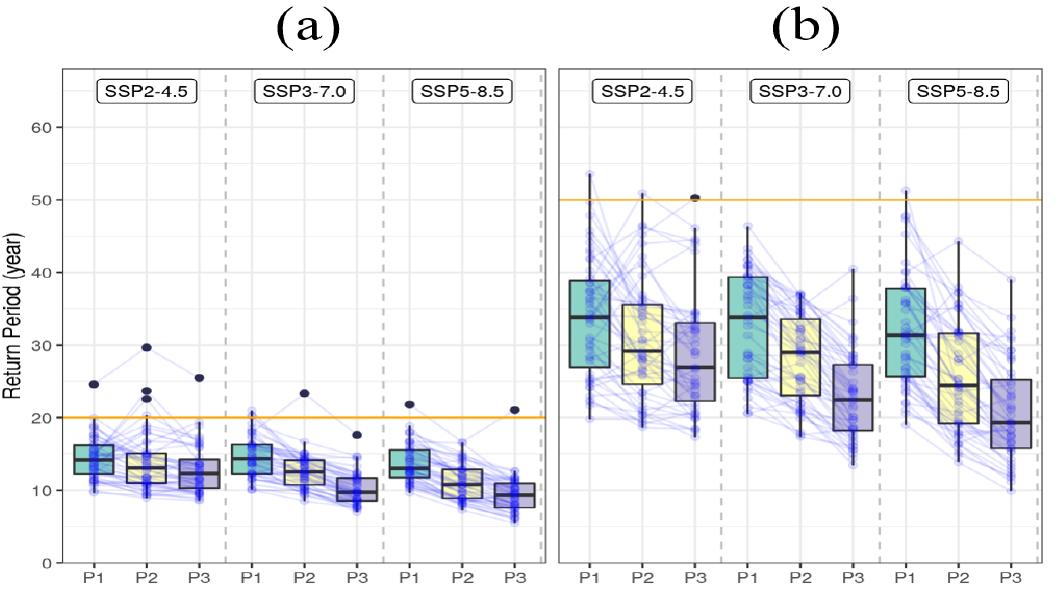
Figure 8. Parallel coordinated boxplots, similar to those in Figure 5, but for ( a ) 20-year and ( b ) 50-year return periods (unit: year) relative to the observed data from 1971 to